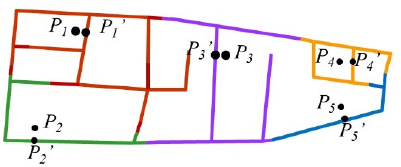
Figure 7. Transmission of auto-waves.